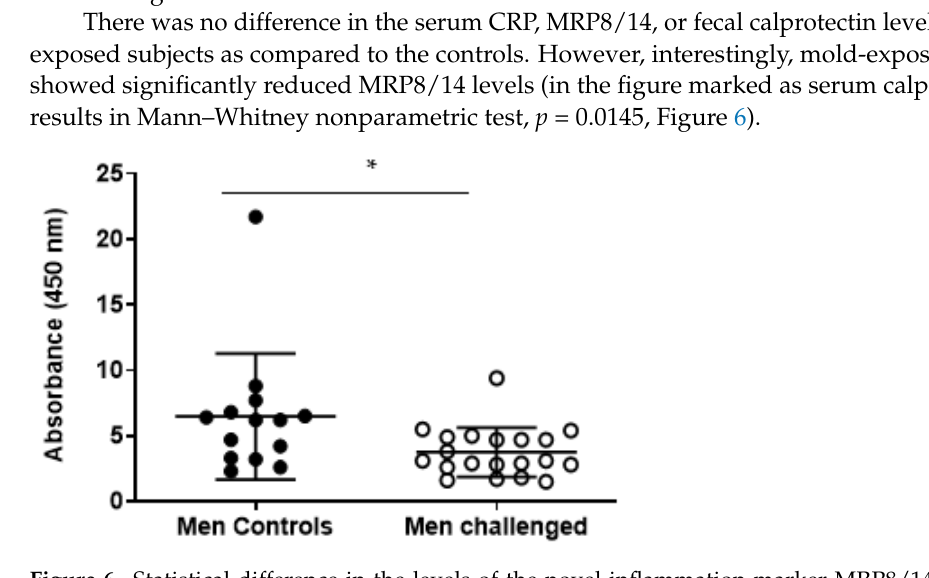
Figure 6. Statistical difference in the levels of the novel inflammation marker MRP8/14 (serum calprotectin) when exposed men are compared to control men, * denotes significant difference, p = 0.0145.